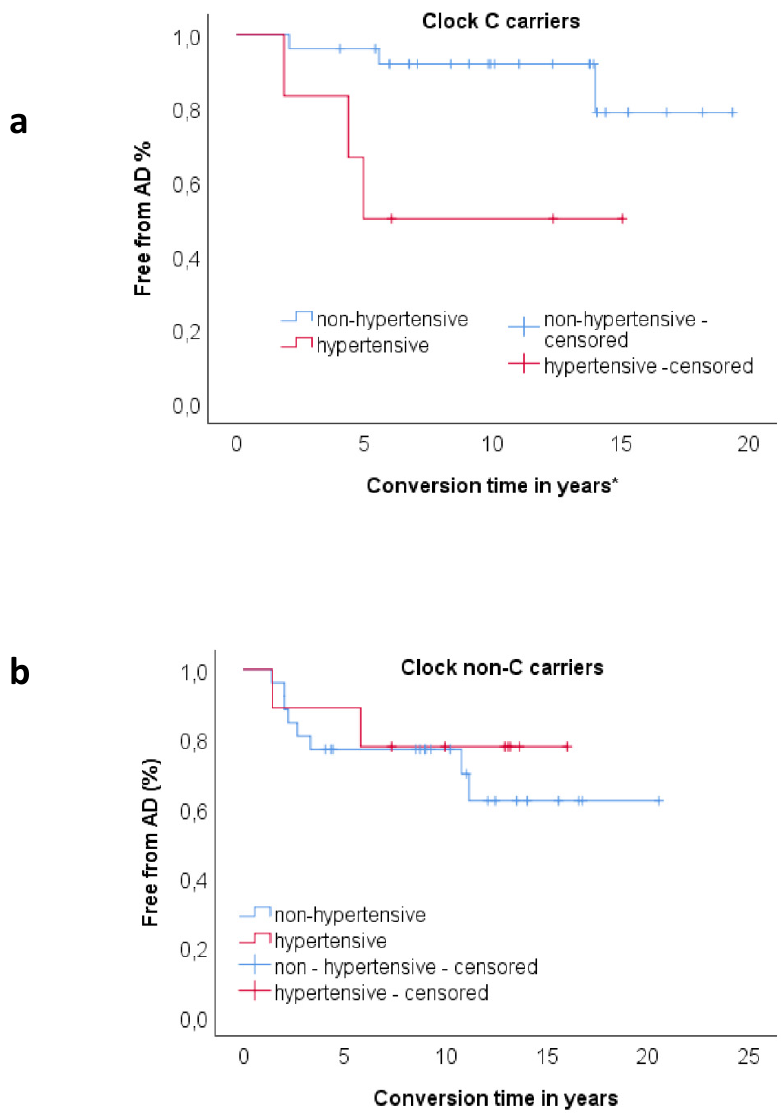
Figure 3. ( a ) Kaplan–Meier survival analysis for comparisons of proportion of progression to AD between hypertensive (n = 6) and non-hypertensive (n = 26) patients in Clock C carriers group. Proportion of progression was higher in hypertensive group (50.00%) compared to non-hypertensive (11.50%). The pairwise log rank comparisons showed significant di ff erence in survival distributions for the hypertensive vs. non-hypertensive ( χ 2 = 5.77, p = 0.017). ( b ) Kaplan–Meier survival analysis for comparisons of proportion of progression to AD between hypertensive (n = 9) and non-hypertensive (n = 26) patients in Clock non C carriers group. The pairwise log rank comparisons showed no significant difference in survival distributions for the hypertensive vs. non-hypertensive ( χ 2 = 0.323, p = 0.570). * For censored cases (non converters) conversion time indicates follow-up time.